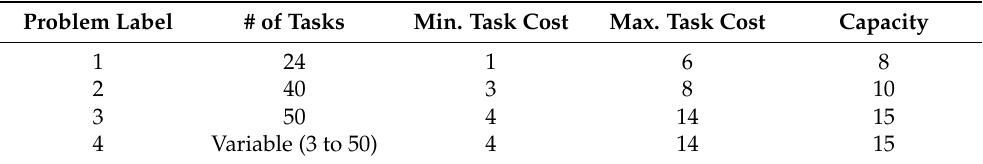
Table 1. Problem conditions in our experiments. Task costs are sampled from the uniform distribution over the interval [Min. task cost, Max. task